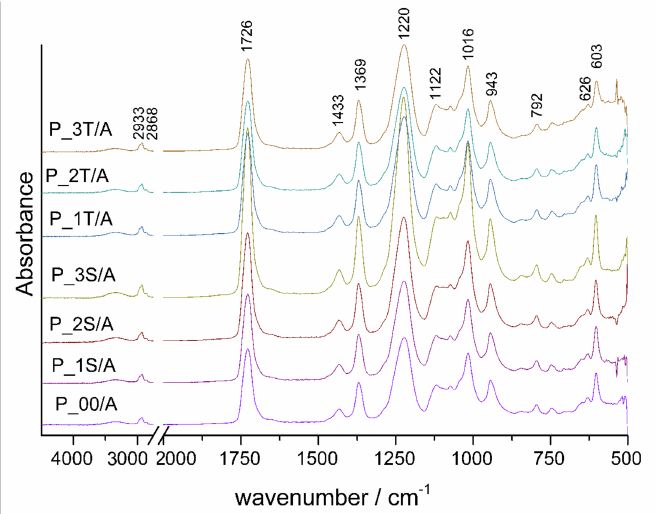
Figure 6. The FTIR spectra of paper A adhesive sample (P_00 / A, P_1S / A, P_2S / A, P_3S / A, P_1T / A, P_2T / A, P_3T /